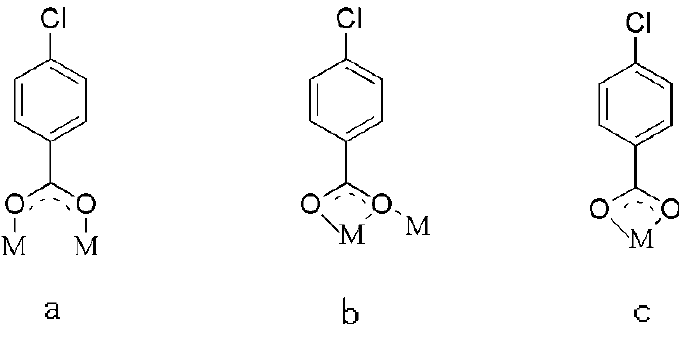
Scheme 1. The coordinated modes of the L1 ligands in 5 .